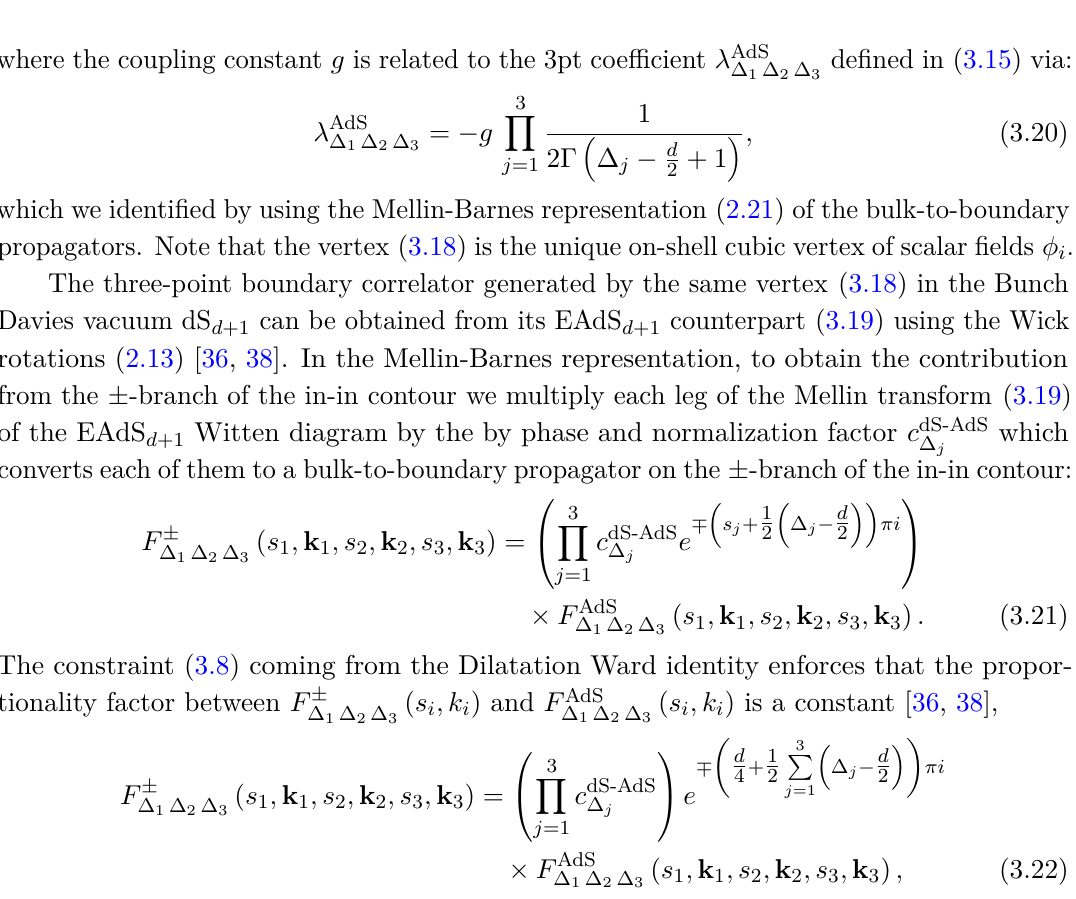
which account ∆ i